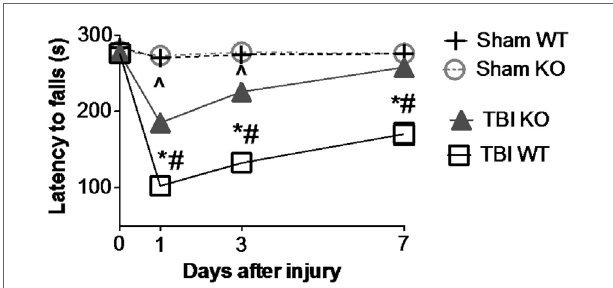
FiGURe 2 | Cathepsin B gene deletion improves neuromotor deficits caused by TBi . Mice with knockout of the cathepsin B gene were assessed for TBI-caused neuromotor deficits. Four groups of mice were assessed: sham wild-type (Sham WT), sham cathepsin B gene knockout (Sham KO), TBI WT, and TBI cathepsin B gene knockout (TBI KO). TBI was modeled by controlled cortical impact (CCI) and mice were subjected to rotarod behavioral neuromotor evaluations before and 7 days after TBI trauma. Longer latency times indicate better neuromotor function. Sham WT and Sham KO animals were not surgically treated the same as TBI animals and were not traumatized. Significantly, knockout of the cathepsin B gene resulted in improved neuromotor defictis and a shorter recovery period compared to TBI WT mice (mean ± SEM, Bonferroni’s multiple comparison test P < 0.05, N = 10 animals/group, *TBI WT vs. Sham WT, ^ TBI KO vs. Sham KO, and # TBI WT vs. TBI KO) (48). Data from cited publication adapted for graphic display.